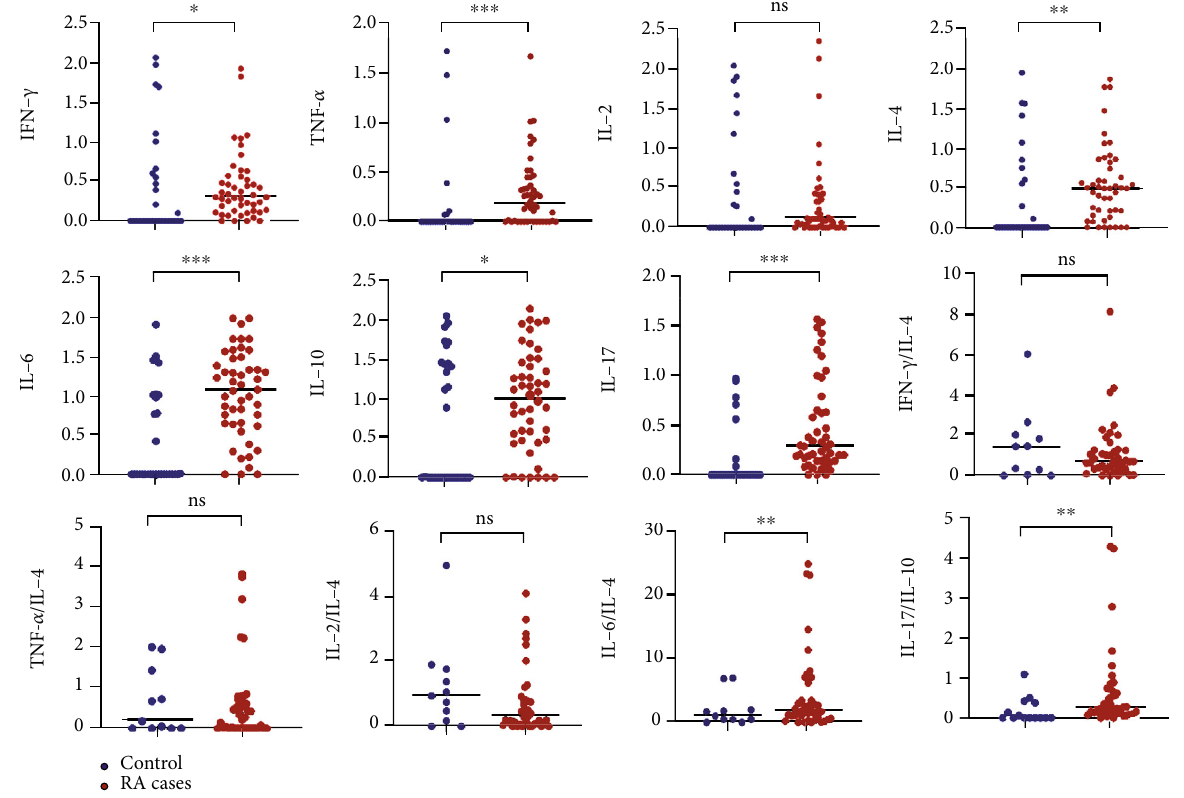
Figure 1: Comparison of T cell cytokines and their ratios between RA cases and healthy controls. ∗ p < 0 : 05 , ∗∗ p < 0 : 01 , ∗∗∗ p < 0 : 0001